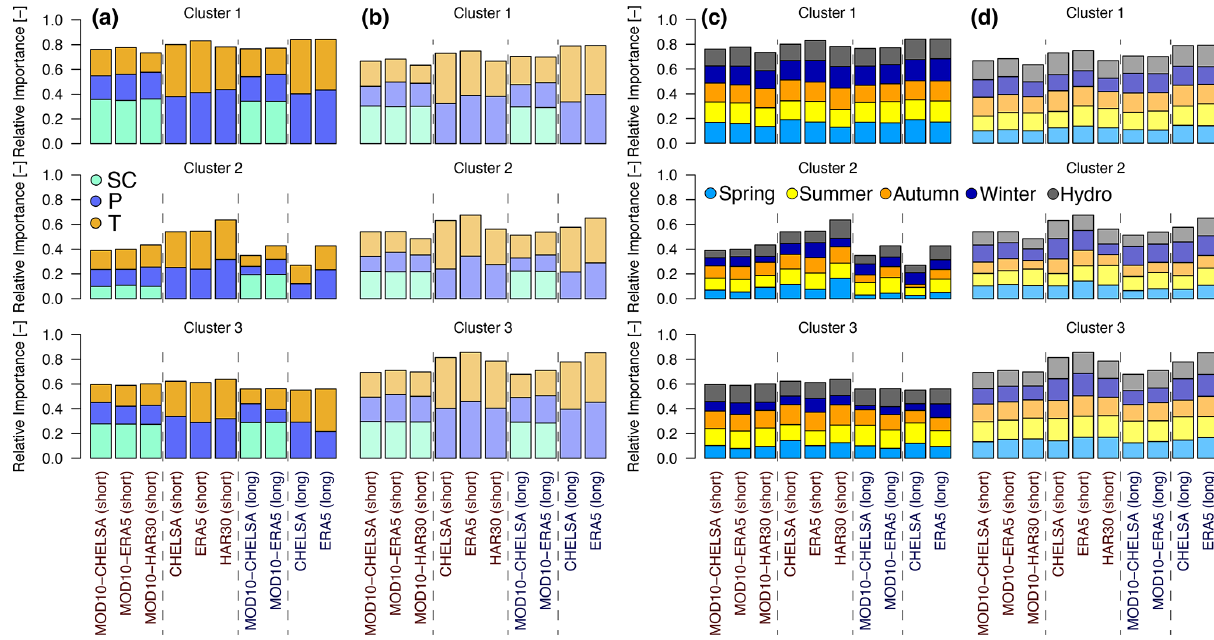
Figure 8. Same information shown in Fig. 7 but with glaciers aggregated according to similar glacier mass balance standard deviations ( k -means clusters) found in Barandun et al.